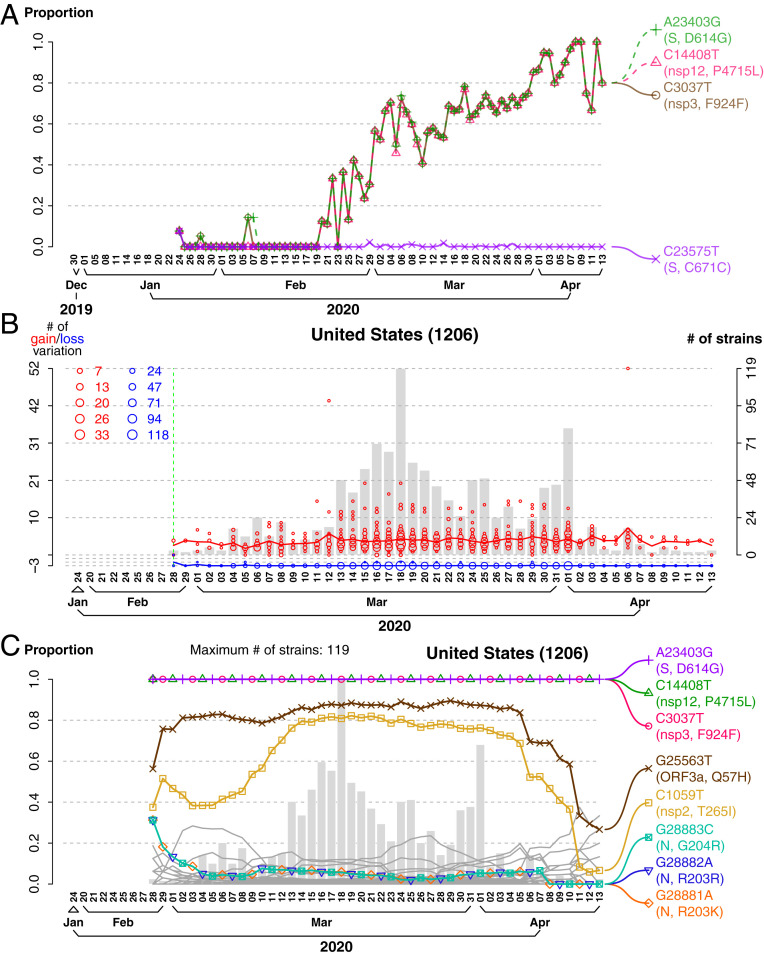
Dominance and persistence of type VI signature SNVs. (A) Temporal proportion of the new variations first coobserved in the strain EPI_ISL_422425 from China on January 24, 2020. Average variation counts per sample for C3037T (F924F), C14408T (P4715L), A23403G (D614G), and C23575T (C671C) first coobserved in EPI_ISL_422425 in China are displayed since January 24, 2020. The TTG signature SNVs persisted, but C23575T was lost immediately in the samples. (B) Number of variation gain and loss in the type VI strains in the United States. The left-hand-side vertical axis indicates the numbers of variation gain and loss. We picked one at random from the strains in the first date of sample collection in the United States as a reference strain. Compared with the first strain in the United States, in addition to the TTG signature SNVs, the type VI strains in the United States had, at most, three additional variations. Blue circles indicate the number of strains that lost the additional variations. Red circles indicate the number of strains that gained variations not in the reference strain. The larger circle represents the larger number of strains that lost/gained the additional variations. Sample size is displayed with a histogram in the background. (C) Temporal frequency of the variations in the type VI strains in the United States. The moving-window proportion on a sample collection date was calculated by dividing the number of variations (e.g., allele G for A23403G) by the number of strains within four closest sample collection dates on each side. Sample size is displayed with a histogram in the background. Note that the variations in this figure were those newly added variations compared to the reference strain from the United States (red circles in B).